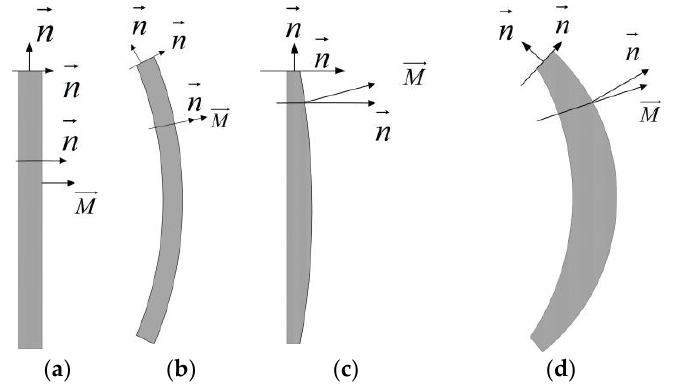
Figure 4. Possible shapes of magnet pole produced from the general pattern. ( a ) Straight PM with uniform thickness; ( b ) Bending PM with uniform thickness; ( c ) Straight PM with uneven thickness; ( d ) Bending PM with uneven thickness.